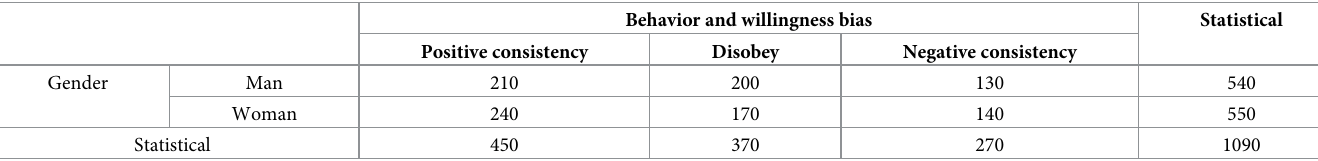
Table 3. Cross analysis of gender and dependent